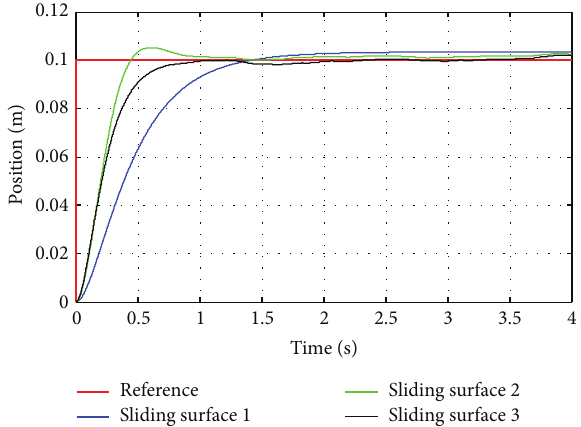
Figure 9: Comparison of the tracking error.